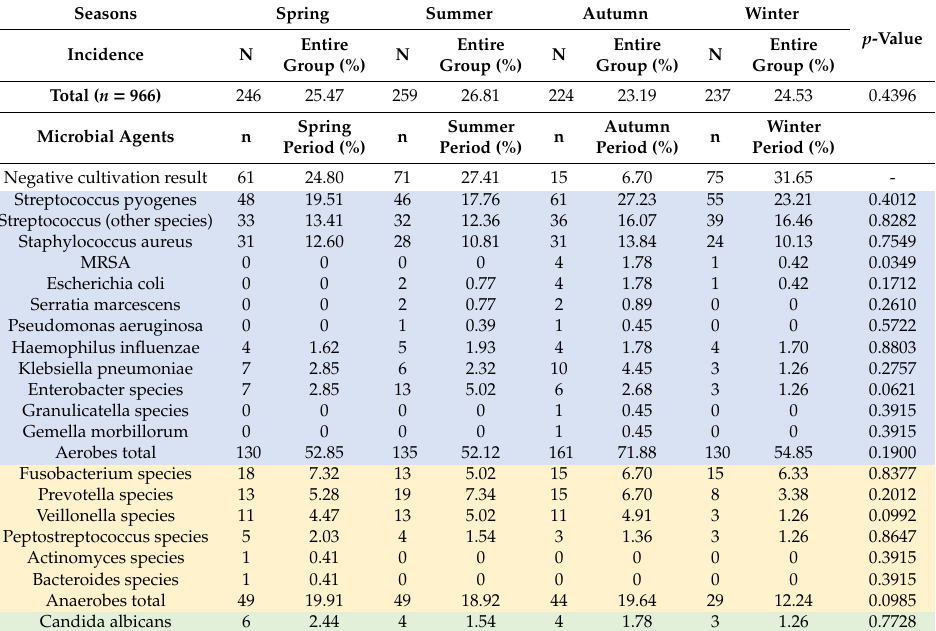
Legends: Table 4 shows PTA patient incidence (N) in the di ff erent seasons. Percentage of incidence in each season was calculated from the total number of patients (966). Next, the individual microbial agents cultivated (n) in the di ff erent seasons are presented. The percentage of the cultivated individual agents in each season was calculated from the total number of patients (N) in the season. For better orientation, the microbial agents are color coded according to their kind: aerobes- blue, anaerobes- yellow, yeast- green. MRSA is methicillin-resistant Staphylococcus aureus